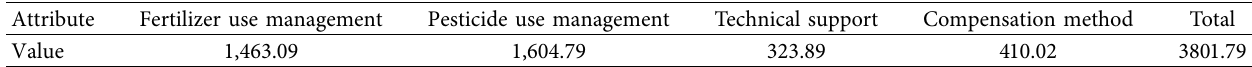
Table 13: Attribute values in the MNL model fused with socioeconomic attributes (unit: